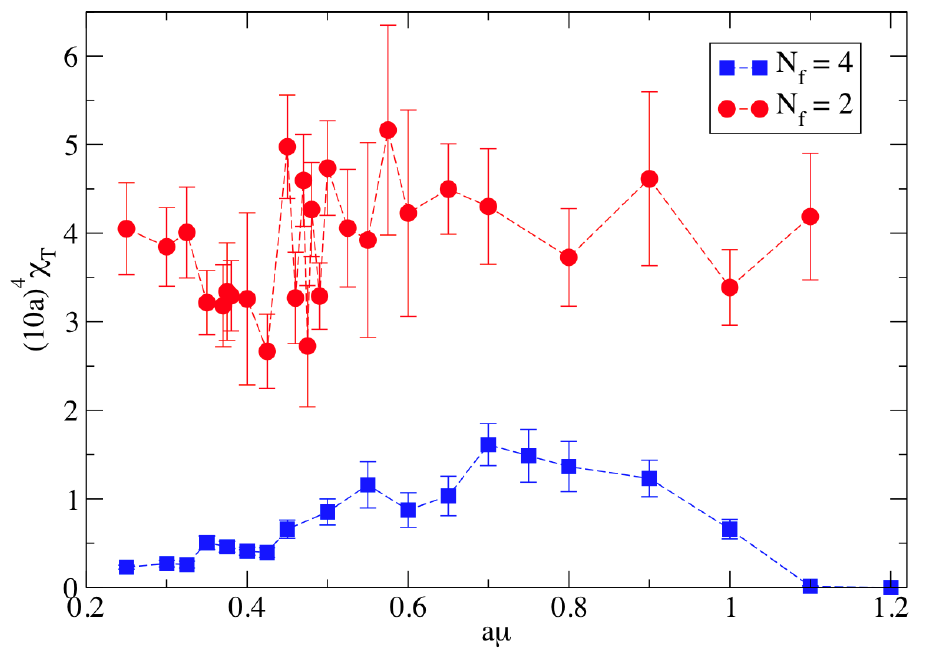
Figure 5. Topological susceptibility versus chemical potential in two-color QCD for two and four flavours, from Ref. [61], in a cold lattice; the expected µ o in lattice units is µ o a (cid:39)